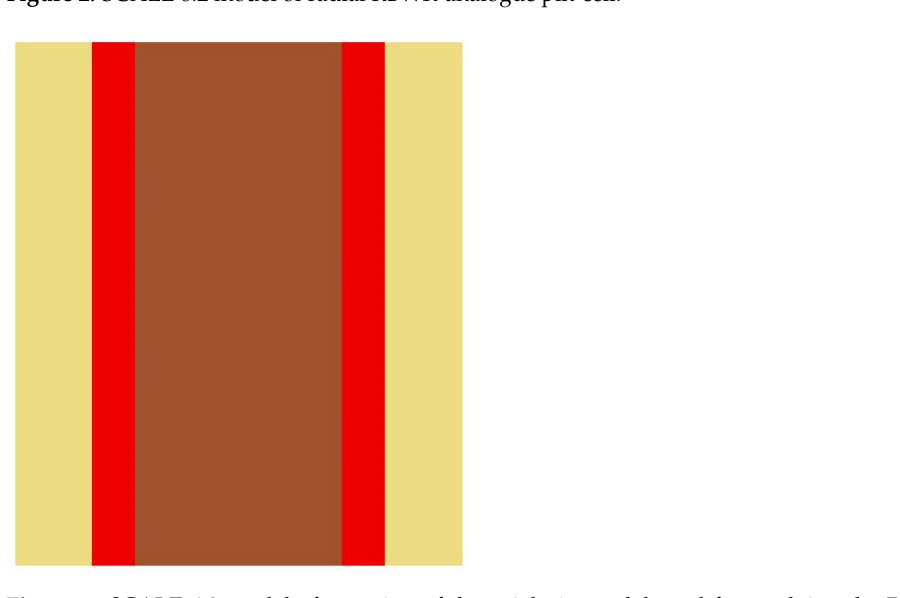
Figure 3. SCALE 6.2 model of a section of the axial pin model used for applying the RPT to an RBWR-analogue